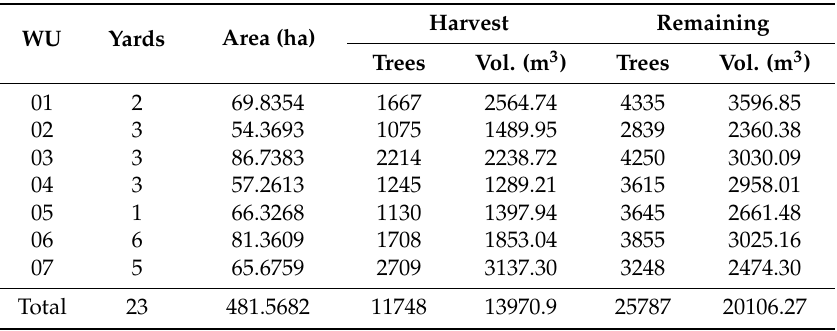
Table 1. Work units (WU), with their respective areas, number of current yards, number of trees and volume destined to first and second/third (remaining) harvest(s) on Genesis Farm. Harvest Remaining WU Yards Area (ha) Trees Vol. (m 3 ) Trees Vol. (m 3